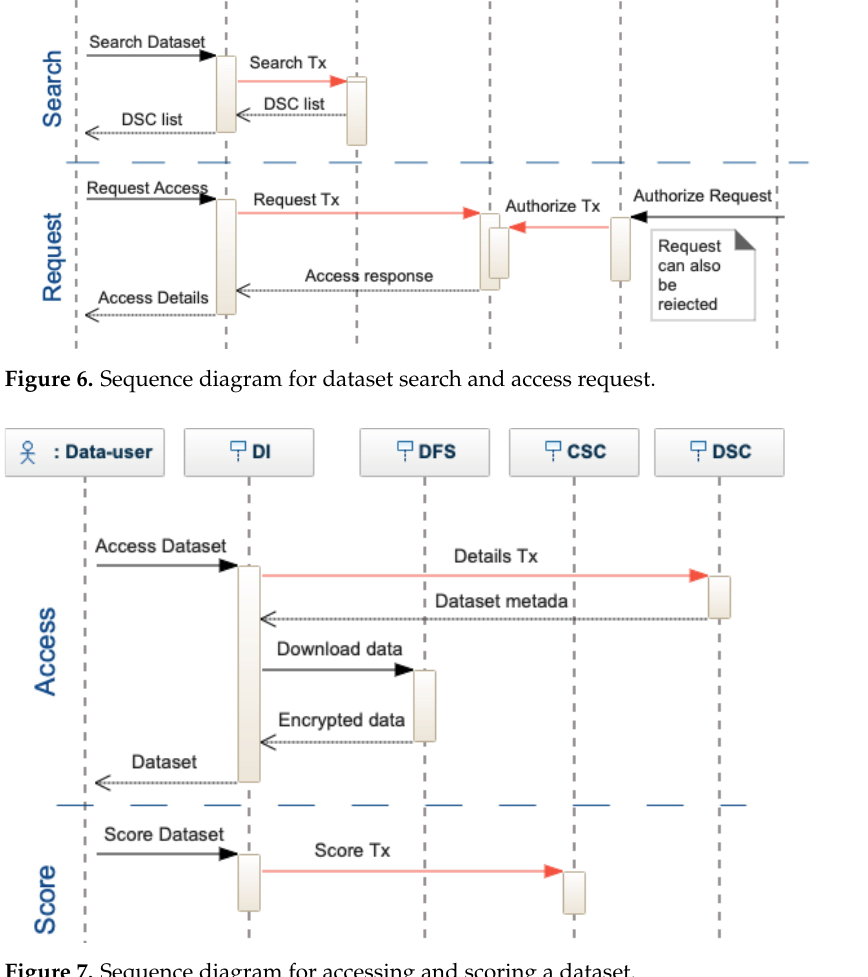
Figure 7. Sequence diagram for accessing and scoring a